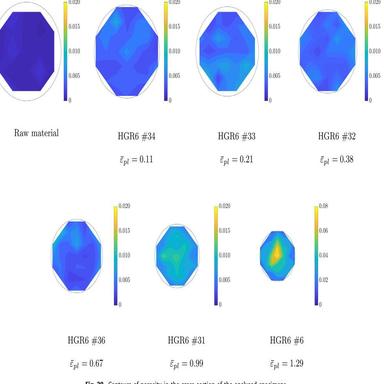
Experimental true equivalent stress - true equivalent plastic strain data fitted to Johnson-Cook plastic model: (a) stainless steel 304L; (b) copper C110.